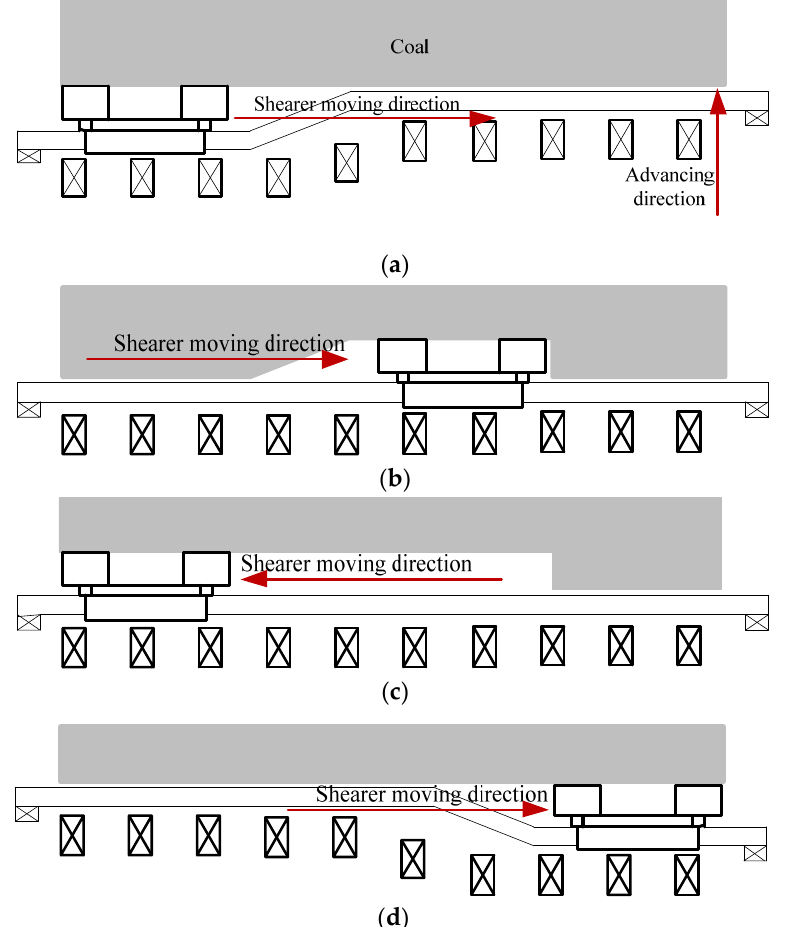
Figure 2. Working diagram of a longwall face. ( a ) Top view of the longwall face when the shearer is located at the left end. ( b ) Schematic diagram of the shearer after cutting into the coal seam. ( c ) Schematic diagram of the shearer returning to the left end. ( d ) Schematic diagram of the shearer at the right end.